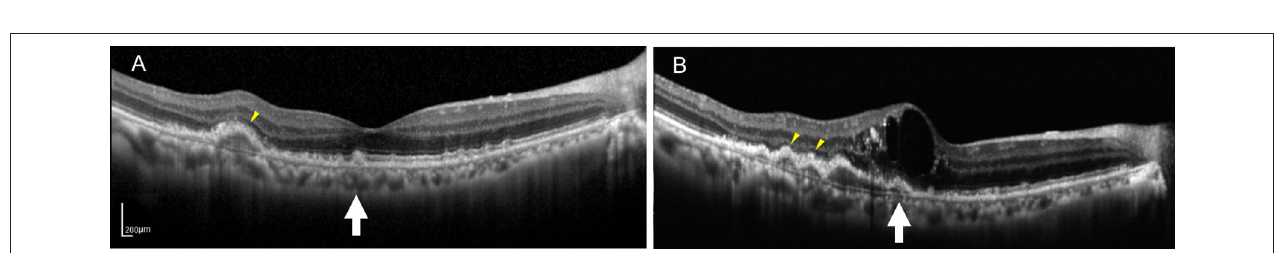
FIGURE 2 | (A) SD-OCT image of a 75-year-old male dry AMD patient showing the multiple, medium-reflectivity drusen with the extensive RPE and EZ damage surrounding the fovea. (B) SD-OCT image of the same patient 1 year later, demonstrating retinal neuroepithelial serous detachment with the additional and expanded drusen in his right macula. Note that the detected drusen (yellow arrowheads and white arrow) developed into the low-reflectivity confluent drusen corresponding to the presence of the above changes. Note that some drusen (white arrow) showed low reflectivity under the hemorrhagic shadow, whereas others appearing hyporeflective (yellow arrowheads) that were not covered by the hemorrhagic